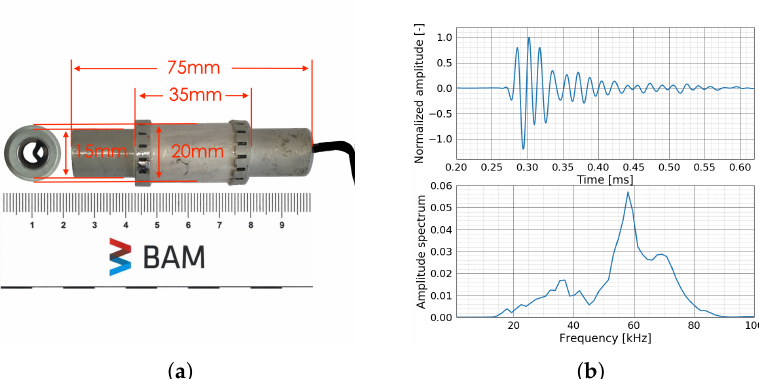
Figure 3. ( a ) Dimension of transducer SO807. ( b ) Response of transducer SO807 recorded in water (top) and the corresponding amplitude spectrum